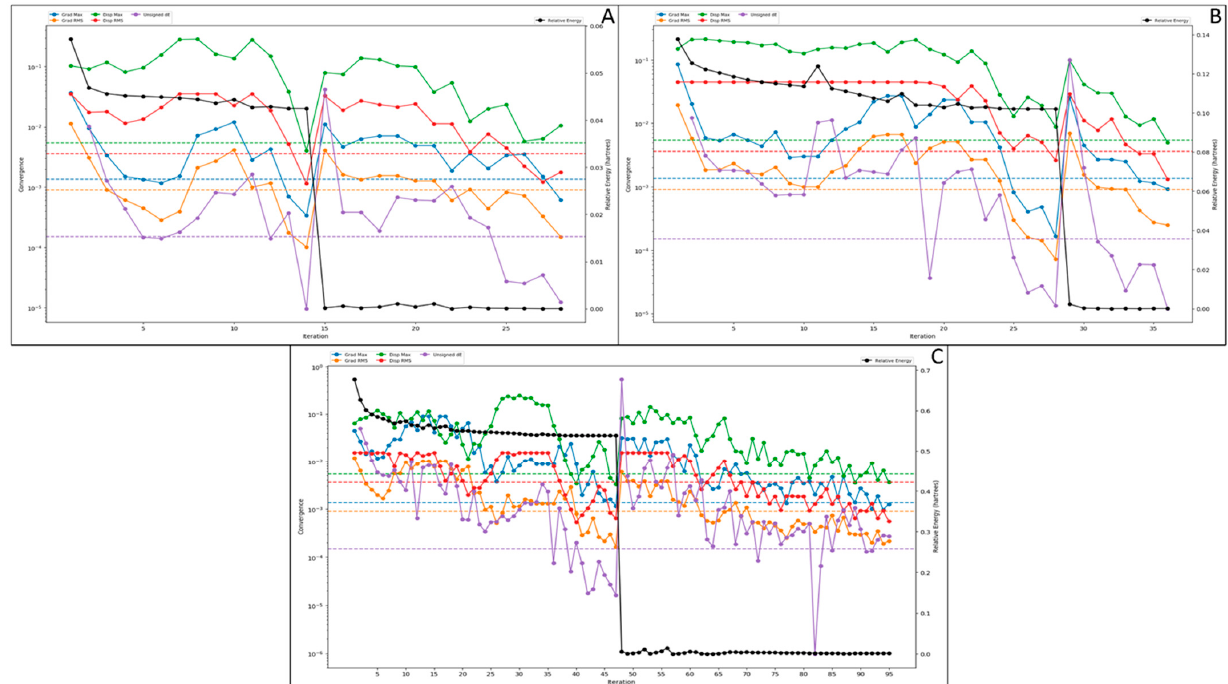
Figure 3. The quantum mechanics convergence for all three compounds: ( A ) mannose; 0 relative energy at 15 iterations, ( B ) PLGA; 0 relative energy at 30 iterations, and ( C ) punicalagin; 0 relative energy at 48 iterations.